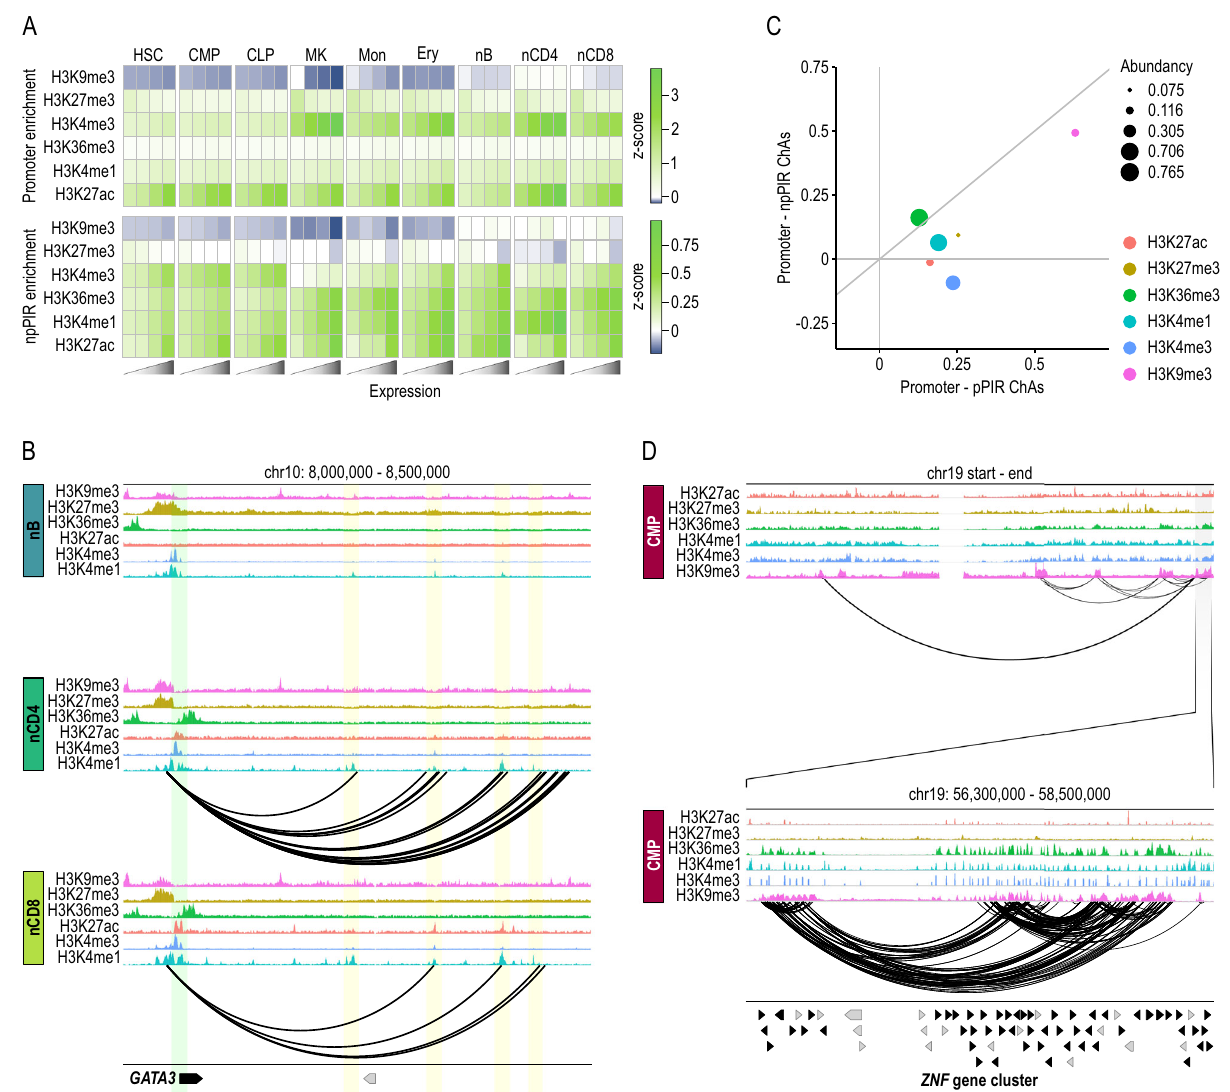
Fig. 3 | liCHi-C identi fi es enhancer – promoter pairs and proteins involved in chromatin organization. A Heatmap representing enrichment (expressed in terms of z-scores) of promoters (top) and non-promoter promoter-interacting regions(npPIRs)(bottom)forhistonemarks.PIRsandpromoterswereclassi fi edby the quartiles level of FPKM expression of the associated gene. HSC hematopoietic stem cell, CMP common myeloid progenitor, CLP common B-cell lymphoid pro- genitor, MK megakaryocytes, Mon monocytes, Ery erythroblast, nB naive B cell, nCD4 naive CD4 + cells, nCD8 naive CD8 + cells. B GATA3 regulatory landscape in naive B (top), naive CD4 + T (middle), and naive CD8 + T (bottom) cells according to histone modi fi cations and liCHi-C data. Green shade depicts the gene promoter,